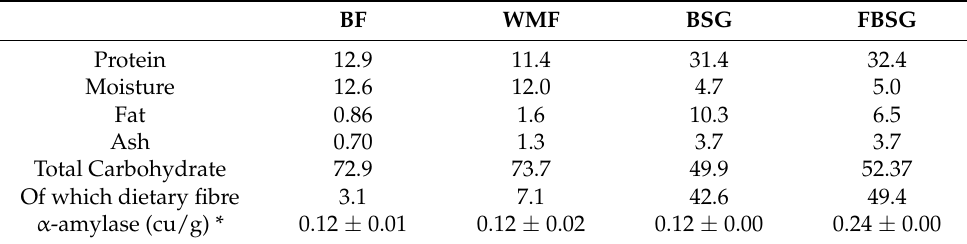
Table 1. Compositional analysis of baker’s flour (BF), wholemeal flour (WMF), brewers’ spent grain (BSG) and fermented brewers’ spent grain (FBSG) flour ingredients in g/100 g.